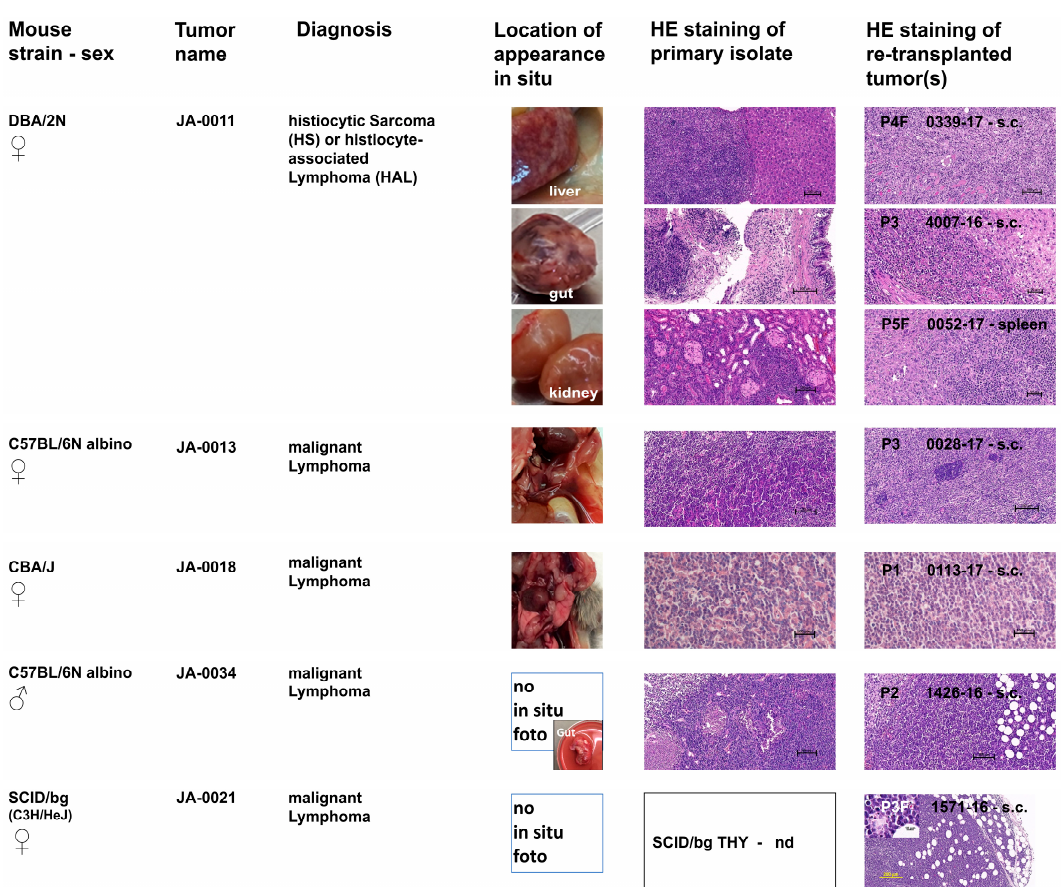
Figure 2. Histopathological characterization of five lymphoma or HAL/HS sMDI. In situ location as well as hematoxylin and eosin (H&E) staining of primary isolated tumor or suspicious tissue and of re-transplanted subcutaneous (s.c.) or spleen tumors (passages P1–P3), or frozen tumor tissue pieces (passages P2F–P5F) were documented by photographs of five hematopoietic sMDIs (JA-0011, JA-0013, JA-0018, JA-0034, and JA-0021). Three tumors were isolated from the gut, liver, or kidney of JA-0011. The histological finding that primary C3H/HeJ isolated lymph node of the sMDI lymphoma named JA-0021 showed a questionable lymphoma or even non-malignant morphology (see Supplementary Materials, Doc.S1-sMDI) indicates that malignant tissue might probably originate from the suspicious, re-transplanted SCID/bg thymus (THY) tissue (HE nd = not done) of the primary recipient H-2 d × H-2 b SCID/bg mouse 1205-16 and not from the primary C3H/HeJ mouse JA-0021. For more details see: Doc. S1-sMDI.